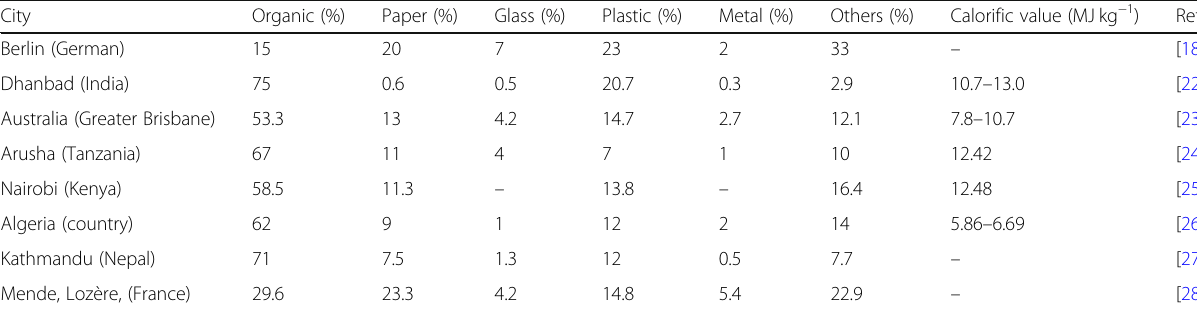
Mende, Lozère, (France)